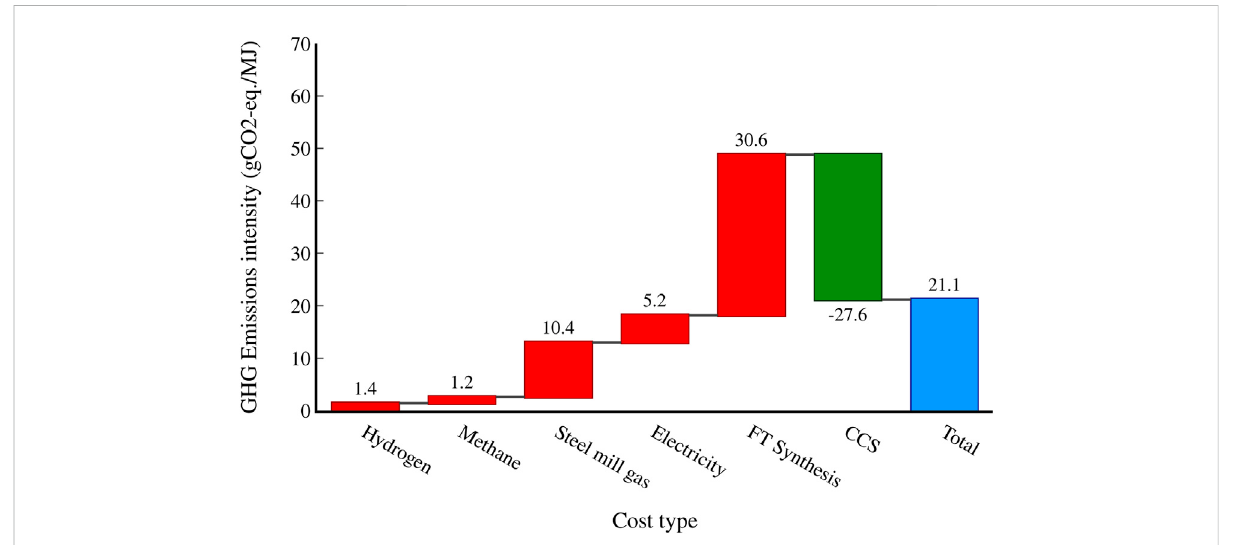
FIGURE 10 Waterfall graph highlighting the contributions of different process segments to the overall process emissions intensity for the scenario with CCS. A capture rate of 90% is